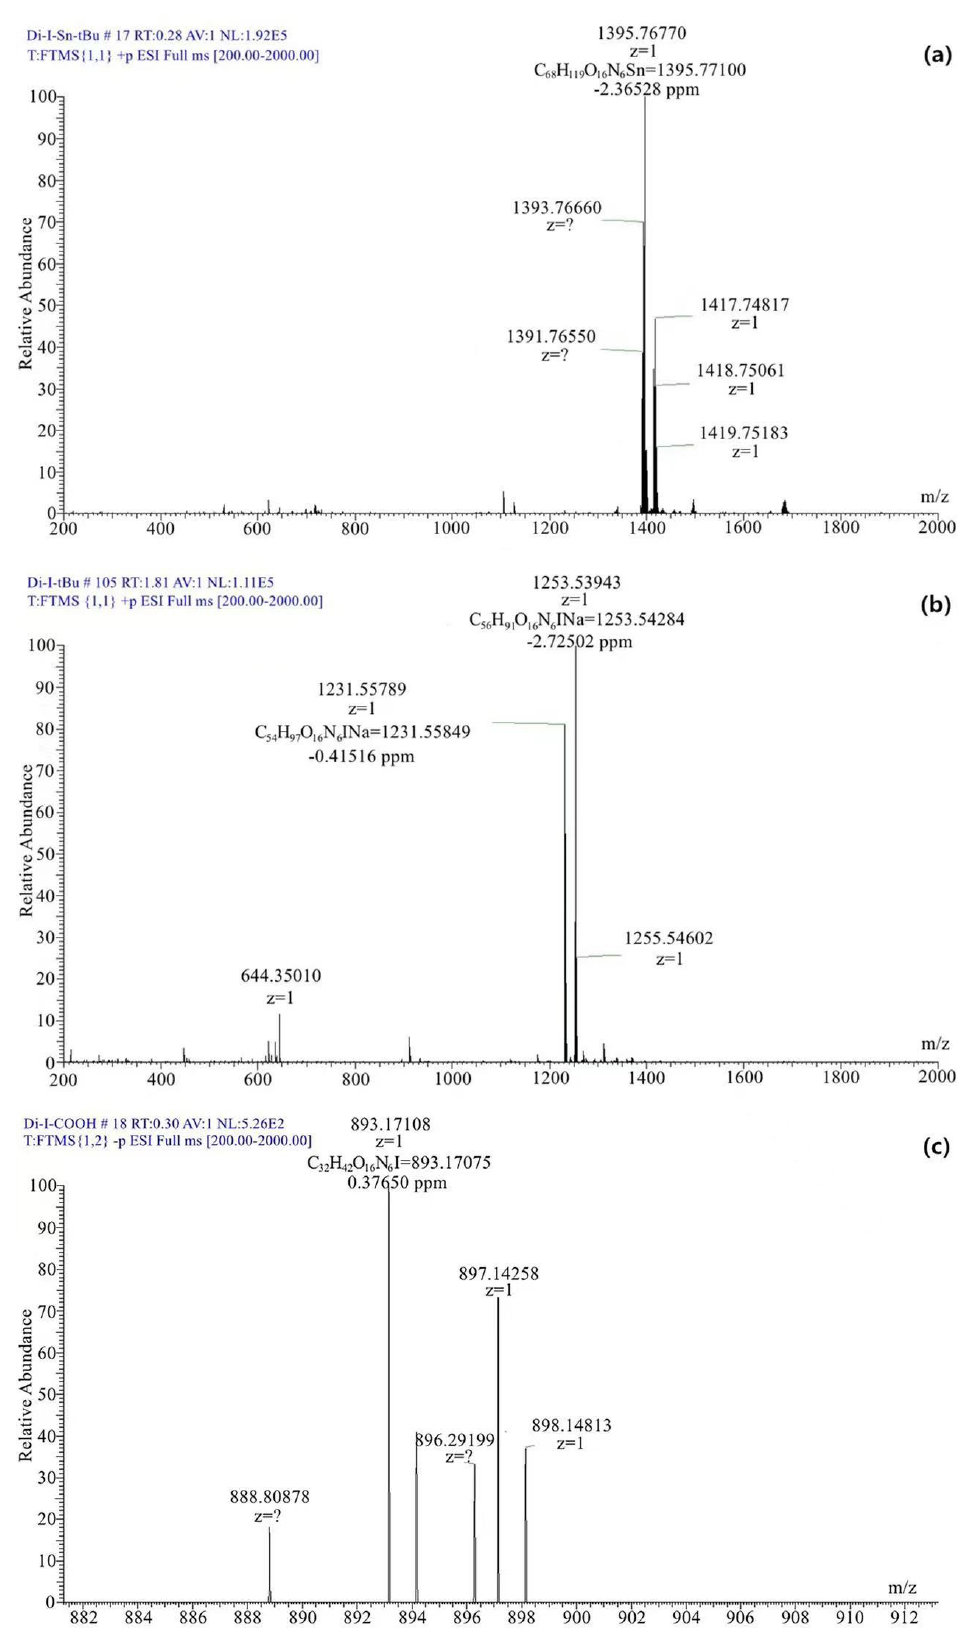
Figure 4. MS analysis ( a ) Compound 4, ( b ) Compound 6, ( c ) Compound 7.